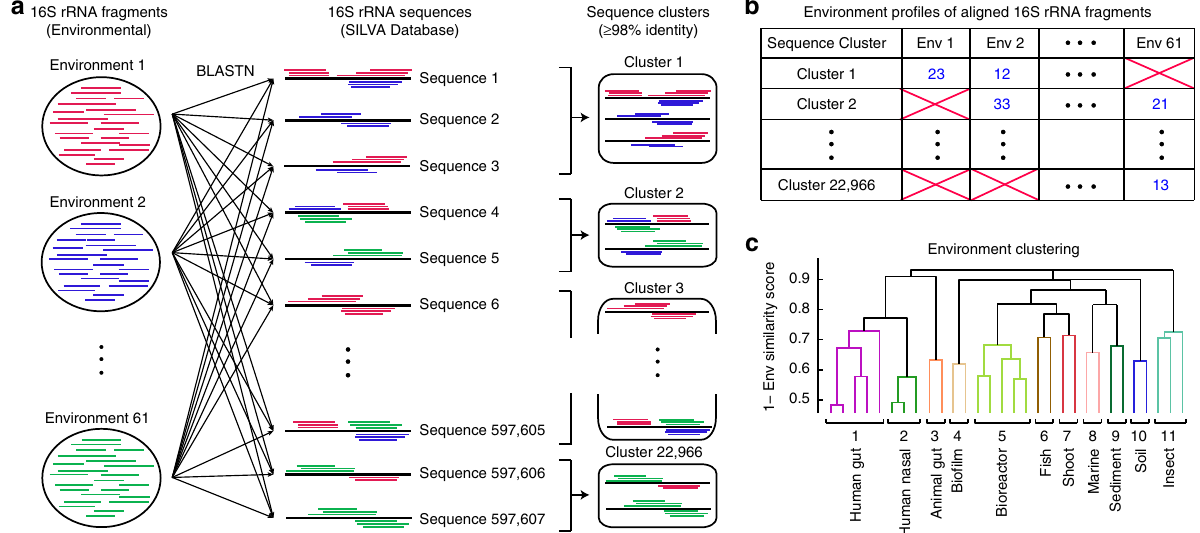
Fig. 1 Clustering similar environments based on 16S rRNA sequence pro fi les. a Predicted 16S rRNA fragments from community sequencing data sets were mapped to full-length 16S rRNA sequences from SILVA database at 98% identity threshold. Redundant full-length sequences were then clustered at 98% identity threshold. b Full-length 16S rRNA sequences were assigned to environments based on mapped fragments. c Environments were clustered based on the similarity in their full-length 16S rRNA sequence pro fi les (Methods). Eleven non-singleton clusters were identi fi